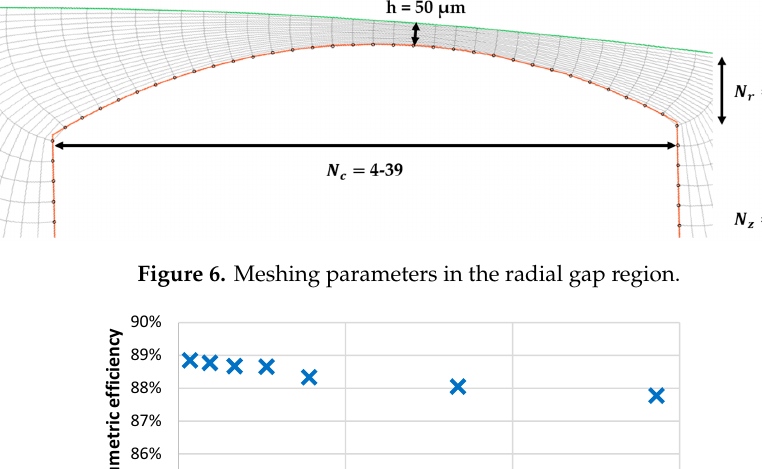
Figure 7. Dependence of the volumetric efficiency on the total cell count N in the rotor region.